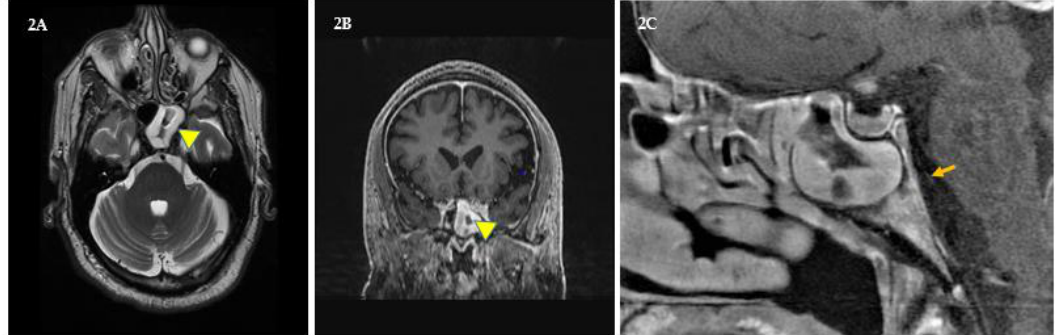
Figure 2. Sphenoid sinusitis. ( A and B ) shows transaxial and coronal views of inflammation in the patient’s left sphenoid sinus (yellow triangles). ( C ) shows a sagittal view of his congested right sphenoid sinus and the plausible path of his right sixth cranial (abducens) nerve (orange arrow) along the pons. However, congestion in the right pons cranial nerve-VI (CN6) region was not seen, and increased intracranial pressure as cause of CN6 palsy was not ruled out.